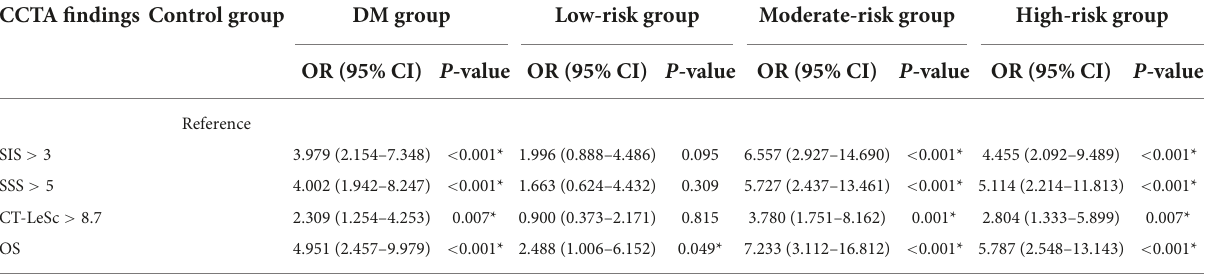
TABLE 9 Binary logistic regression analysis of the CCTA findings.